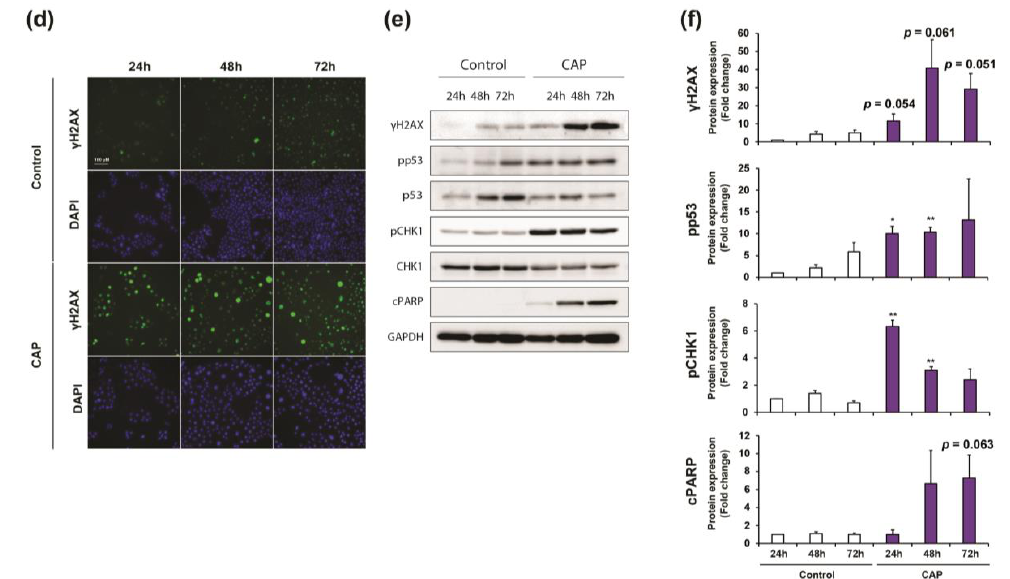
Figure 6. ( a , d ) Representative images of phosphorylated H2AX ( γ H2AX) analyzed by immunofluorescence in EGI-1 ( a ) and HuCCT1 ( d ) CCA cells after 24 h, 48 h and 72 h of exposure to culture medium pretreated with CAP for 3 min. (9 kV, 30 kHz, 14%, gap of 7 mm). Magnification, ×10. ( b , e ) Representative images of western blot analysis of cleaved PARP, phosphorylated and total p53, phosphorylated and total CHK1 and phosphorylated H2AX in EGI-1 ( b ) and HuCCT1 ( e ) cells treated in the same conditions. ( c , f ) Densitometry analysis of western blot from cleaved PARP, phosphorylated p53, phosphorylated CHK1, and phosphorylated H2AX. Values are expressed as means ± SEM from three independent cultures. *, p < 0.05; **, p < 0.01; compared with control cells.